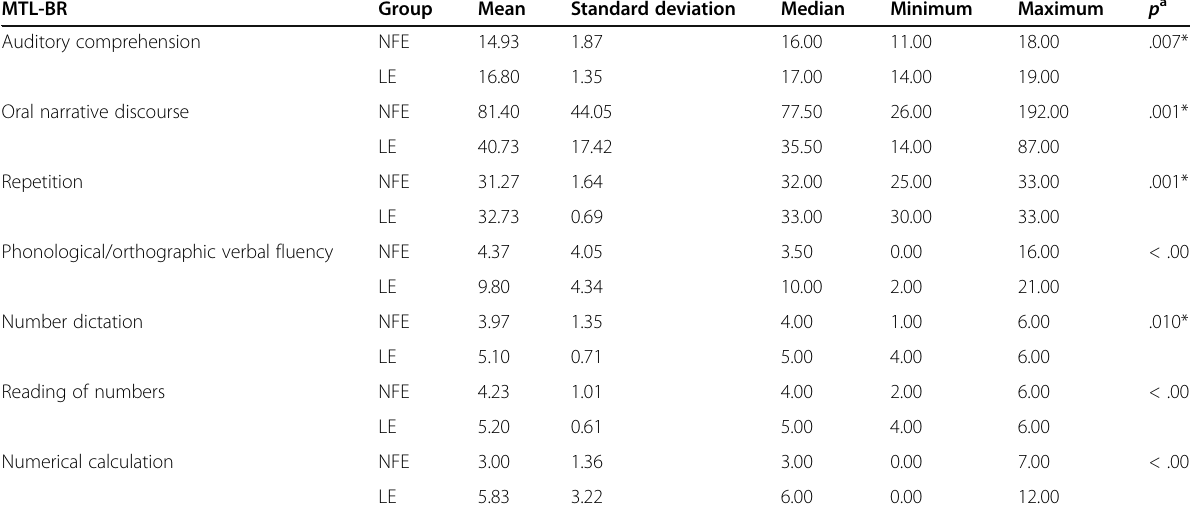
Table 1 MTL-BR tasks in which statically differences where found between NFE and LE groups